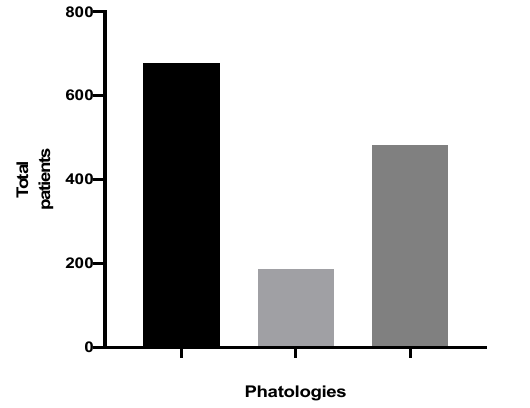
Figure 3. Distribution of pathologies in OSAS patients.